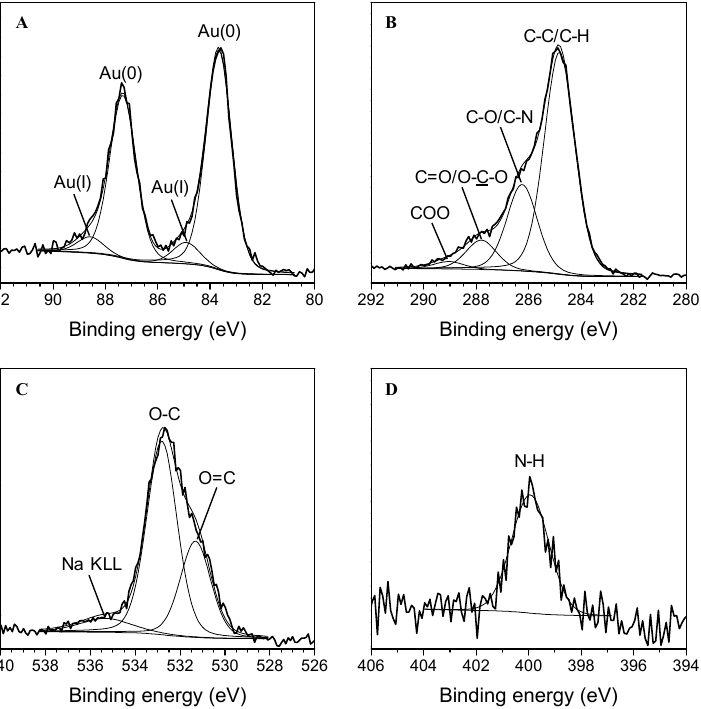
Figure 4. High-resolution XPS spectra of the AuNPs: Au 4f ( A ), C 1s ( B ), O 1s ( C ), and N 1s ( D )